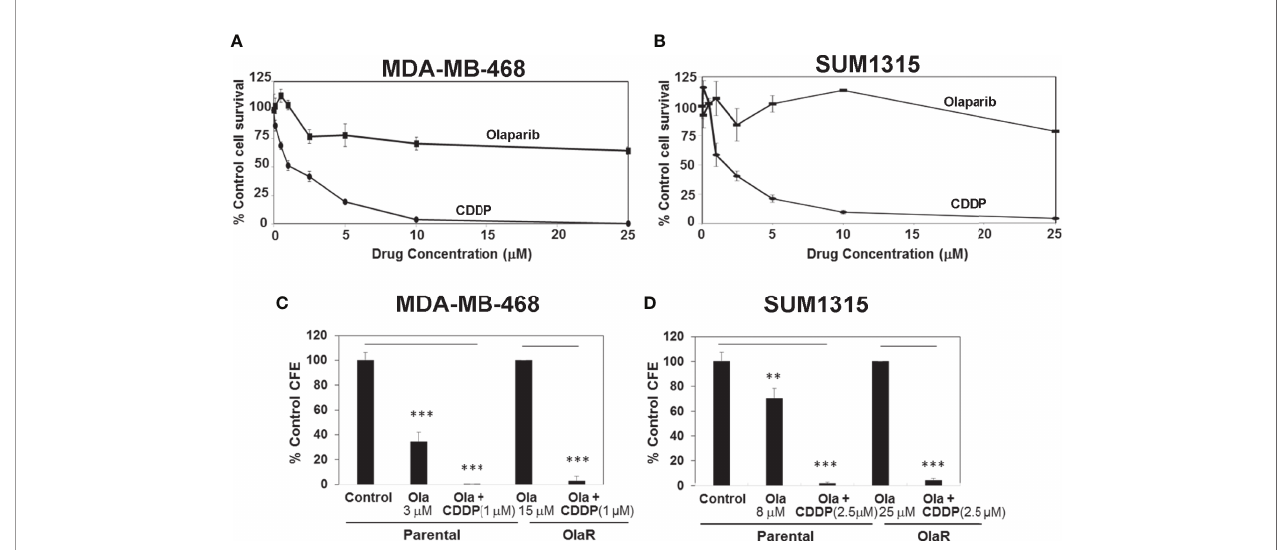
FIGURE 3 | Olaparib resistant (OlaR) TNBC cells remain sensitive to cisplatin (CDDP). (A, B) Determination of olaparib and CDDP sensitivities of OlaR MDA-MB-468 (A) and SUM1315 (B) cells by MTT assays. (C, D) Clonogenic analysis of olaparib and CDDP sensitivities in parental and OlaR MDA-MB-468 (C) and SUM1315 (D) cells. Parental MDA-MB-468 and SUM1315 cells were treated with 3 or 8 m M olaparib, respectively. OlaR cells indicate MDA-MB-468 and SUM1315 cells maintained in 15 or 25 m M olaparib, respectively. Olaparib treated parental and OlaR MDA-MB-468 and SUM1315 cells were treated with 1 or 2.5 m M CDDP, respectively. Results are expressed as mean ± S.D. (percent of control colony formation ef fi ciency) from three independent experiments. **P < 0.01, ***P <